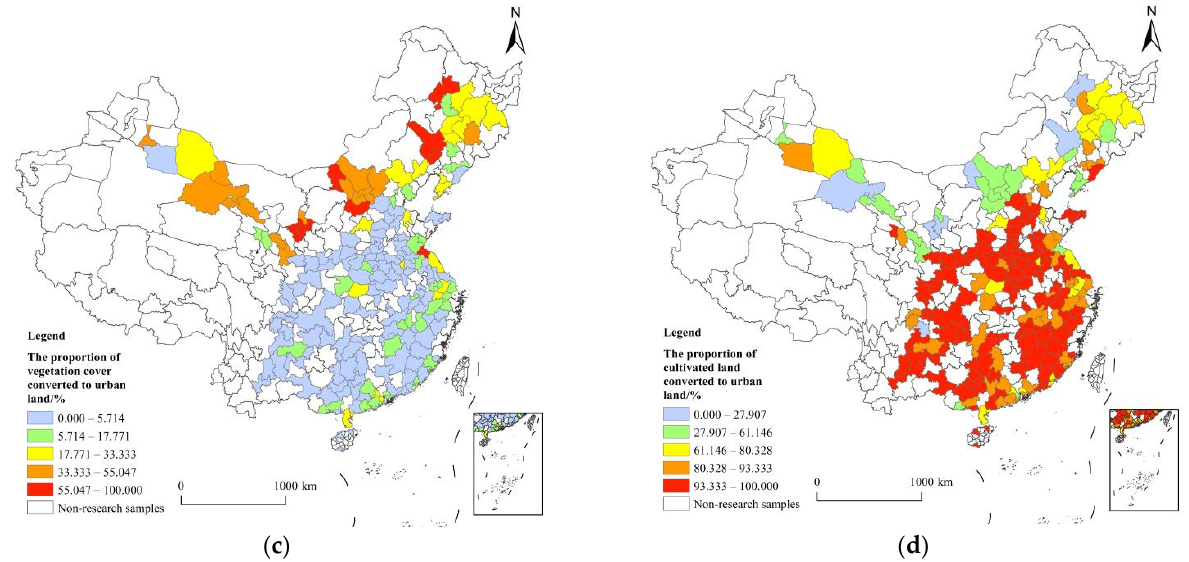
Figure 8. The proportion of non-urban land converted to urban land in the cities that first opened HSR during 2010 to 2019. ( a ) The proportion of barren land converted to urban land; ( b ) the proportion of water body converted to urban land; ( c ) the proportion of vegetation cover converted to urban land; ( d ) the proportion of cultivated land converted to urban land.